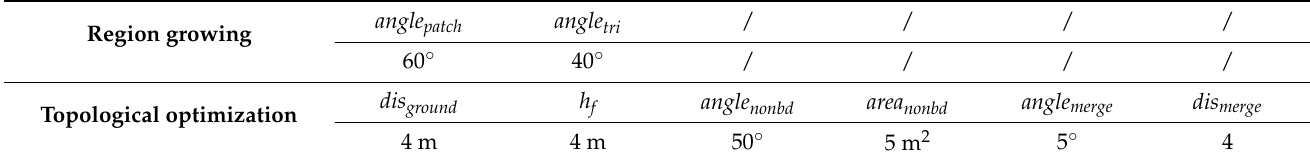
Table 4. The configuration of other